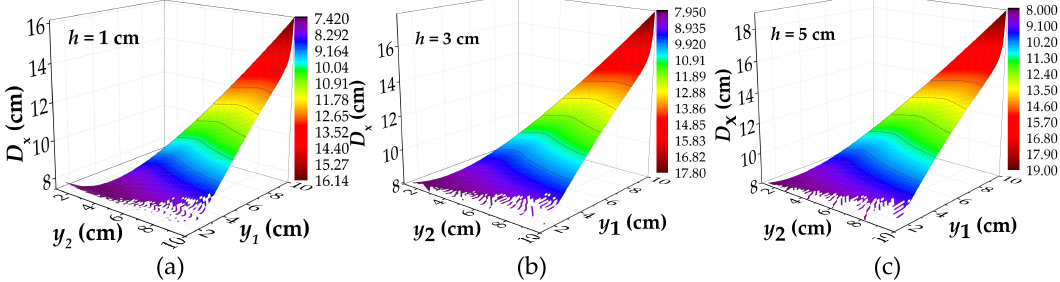
Figure 8. The calculated results of D x under the di ff erent values of h : ( a ) the calculated results of D x under h = 1 cm; ( b ) the calculated results of D x under h = 3 cm; ( c ) The calculated results of D x under h = 5 cm; D x : the intersecting point distance between curves of magnetic flux component of x direction at di ff erent lift o ff heights; y 1 and y 2 : the lift o ff height; h : the depth of corrosion defect.